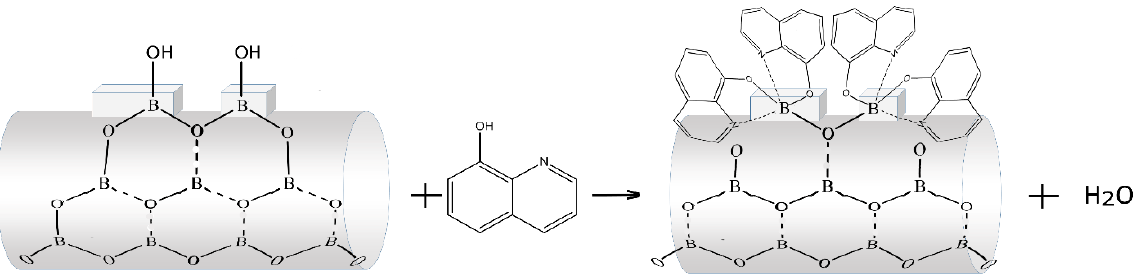
Figure 10. Scheme of the BLC formation on the sharp edges of ledges of boron oxide wires.